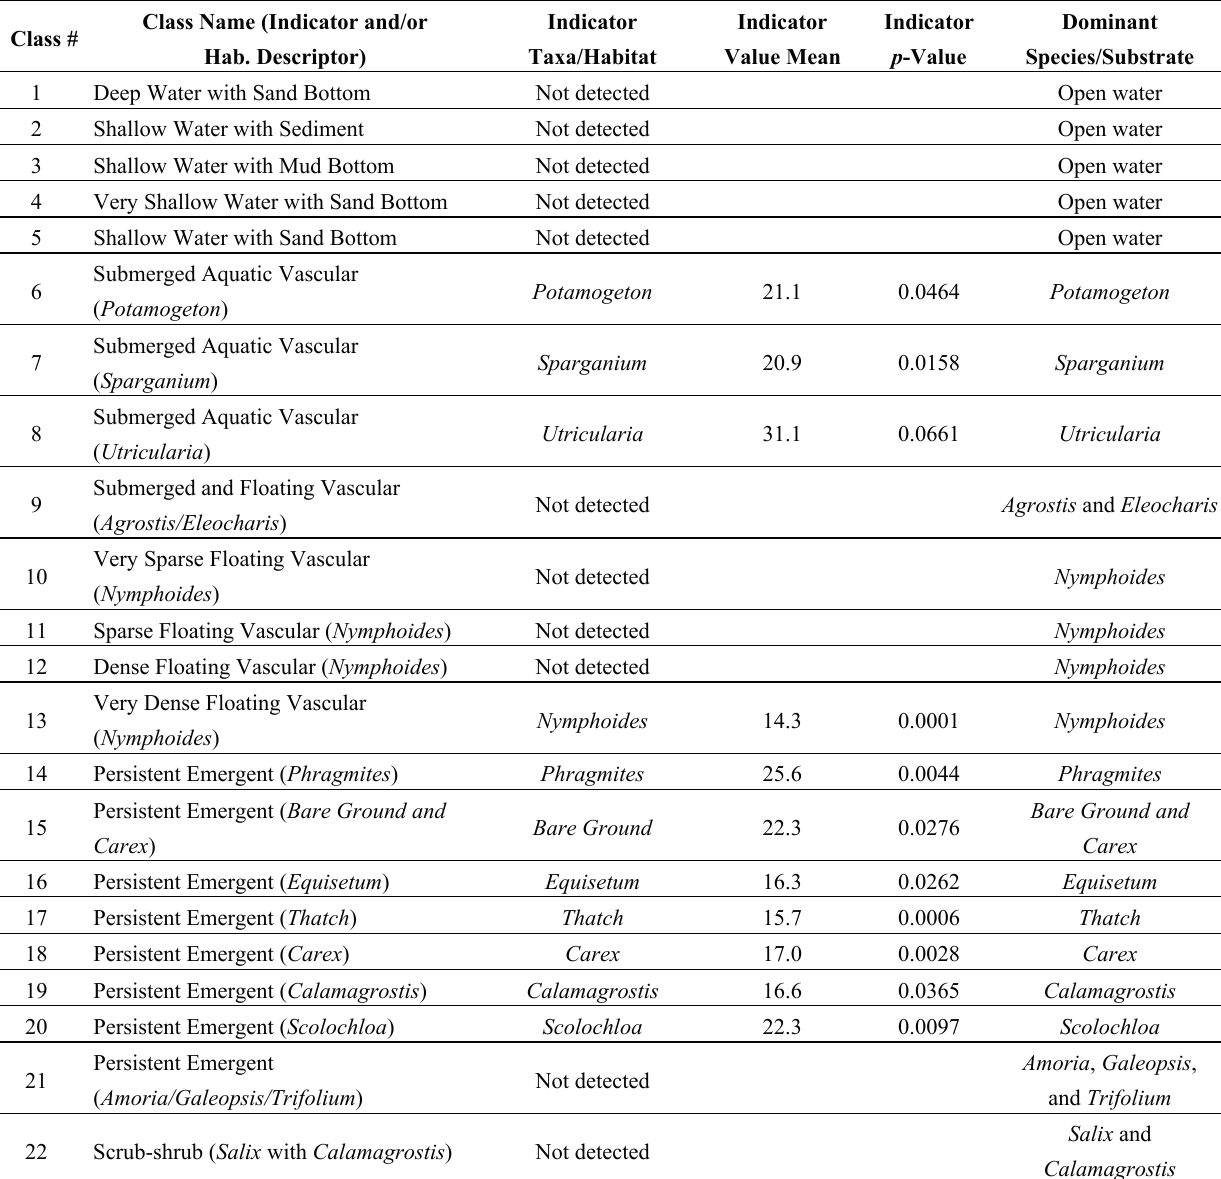
Table 2. Indicator and dominant species of Level 5 of the classification. Higher